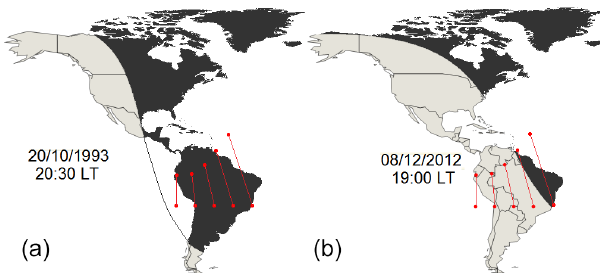
Figure 7. Solar terminator and geomagnetic field lines projected onto the American sector map corresponding to the date and time of the observations made in Jicamarca (a) and Alcântara (b) .